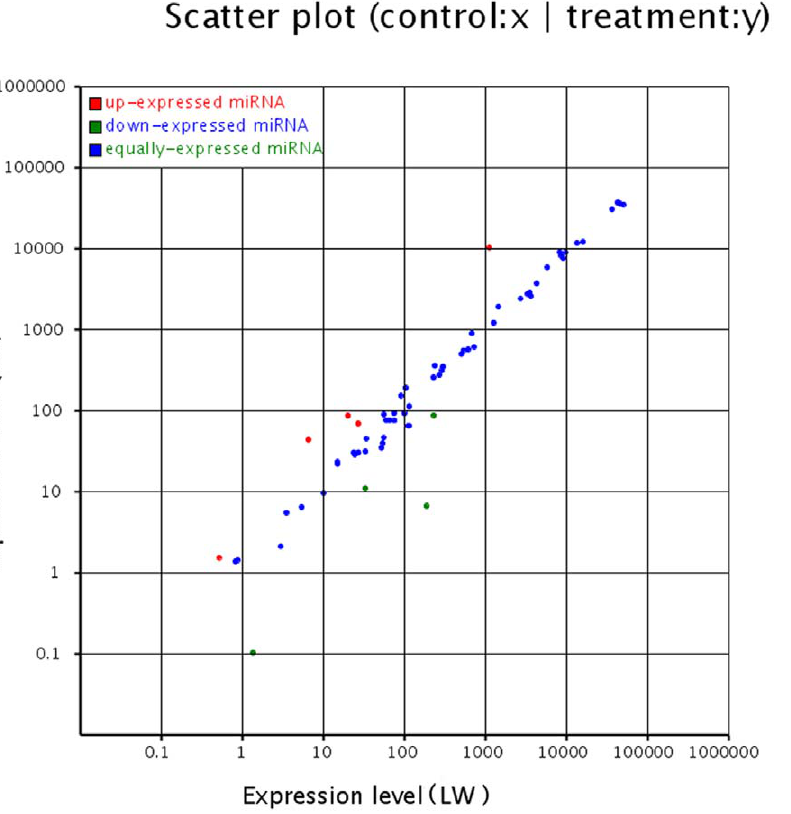
Figure 1. The differentital expressions of porcine conversed miRNAs between Large White and Meishan were shown. Each point in the figure represents a miRNA. Red points represent miRNAs with fold change . 2, blue points represent miRNAs with 1/2 , fold change # 2, green points represent miRNAs with fold change # 1/2.